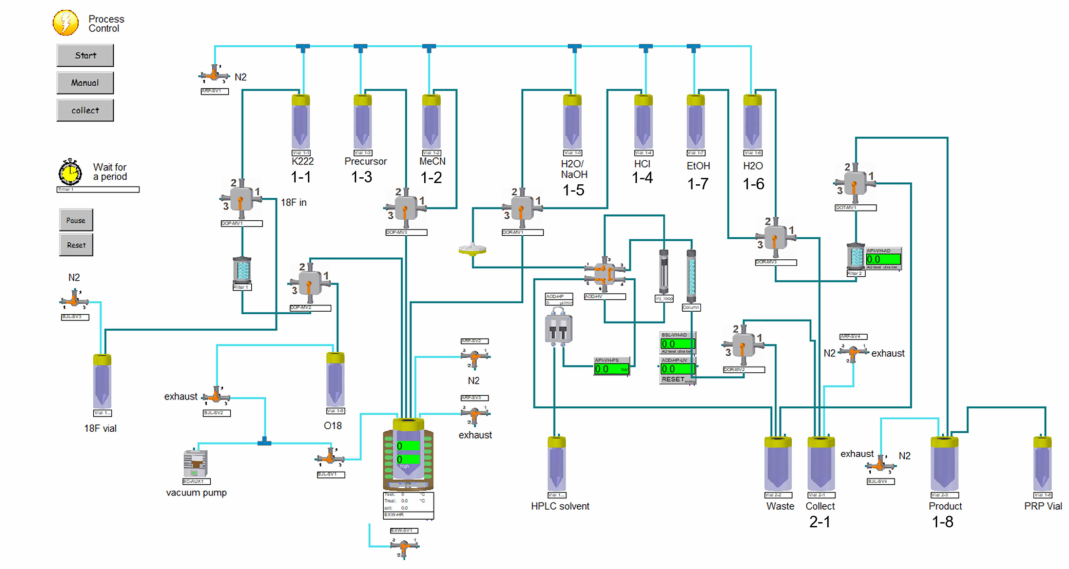
Figure 6. Schematic overview of the EZAG module surface for the synthesis of [ 18